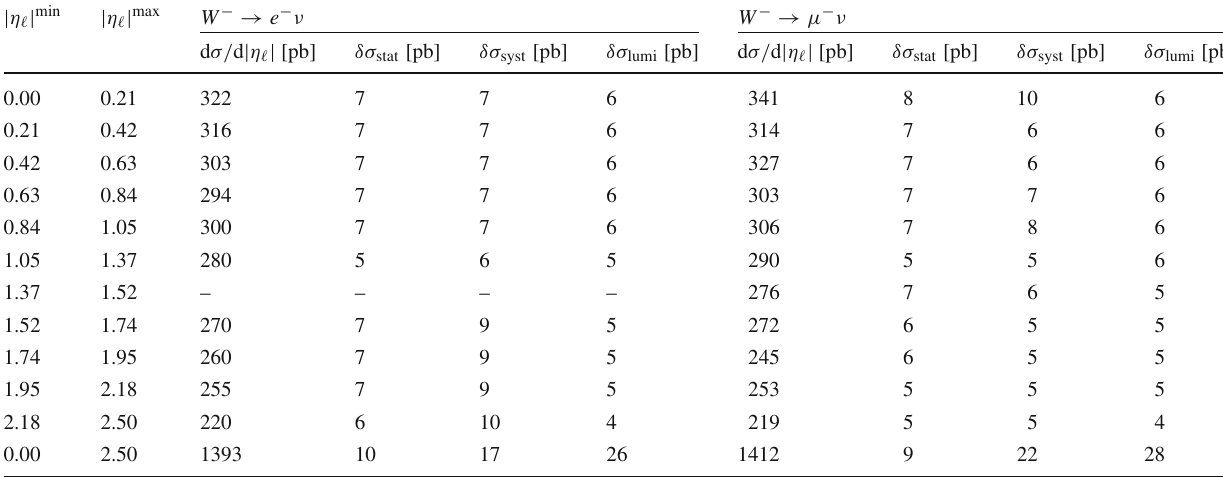
Table 4 Measured fiducial W − → (cid:5) − ν differential and integrated cross sections for electron and muon channels | η (cid:5) | min